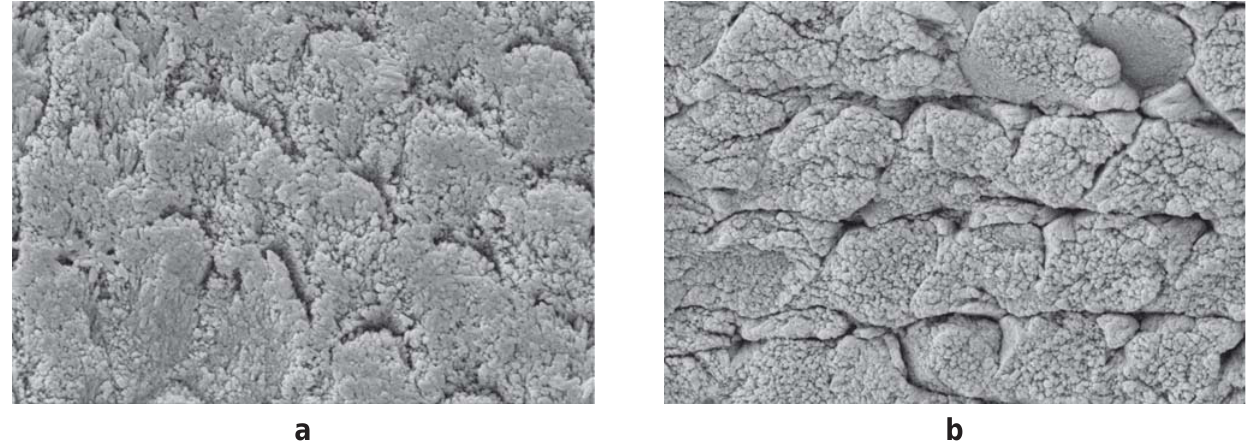
FIGURE 1- SEMs of ground (1a) and intact (1b) enamel surfaces etched with 34% phosphoric acid. Dissolution of prism core and boundaries can be observed (x10,000)